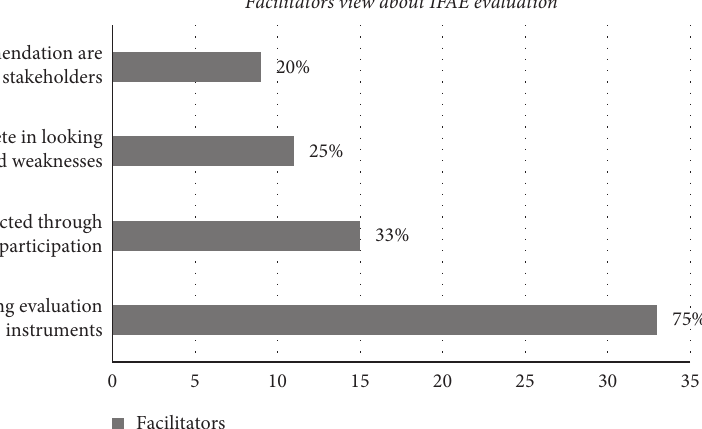
Figure 2: IFAE evaluation.